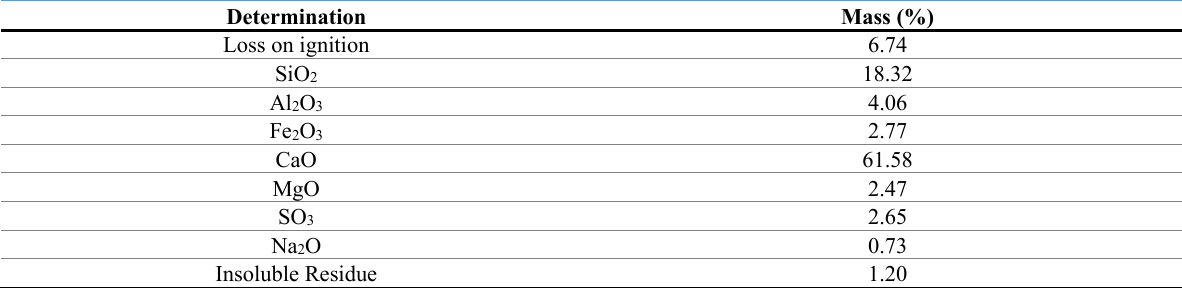
Table 2. Chemical characterization of cement CP-II-F